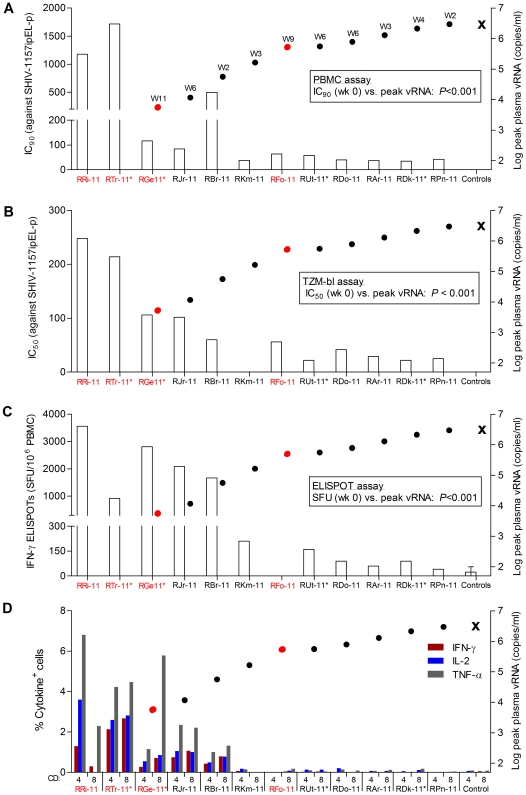
Immune parameters associated with protection.Vaccinees were ranked in ascending order of peak viremia after all virus challenges (animals that received the high-dose challenge are shown in red), and immune parameters measured on the day of 1st low-dose virus challenge are presented. W, week of peak viremia. (A) Neutralizing antibody titer (IC50) measured by TZM-bl cell-based assay vs. peak plasma vRNA. (B) Neutralizing antibody titer (IC90) measured by PBMC-based assay vs. peak plasma vRNA. (C). SIV Gag- plus HIV-1 Tat-specific IFN-γ ELISPOTs vs. peak plasma vRNA. (D) SIV Gag- plus HIV-1 Tat-specific CD4+ and CD8+ T cells producing IL-2, IFN-γ and TNF-α vs. peak plasma vRNA. Inverse correlations of peak vRNA with cellular (P<0.001) and nAb (P<0.001) responses were determined by Spearman analyses. The mean peak plasma viremia of all controls is shown by the X mark. All control animals were tested in neutralization (TZM-bl, PBMC) and ELISPOT assays; one control animal was included in the ICS assays.